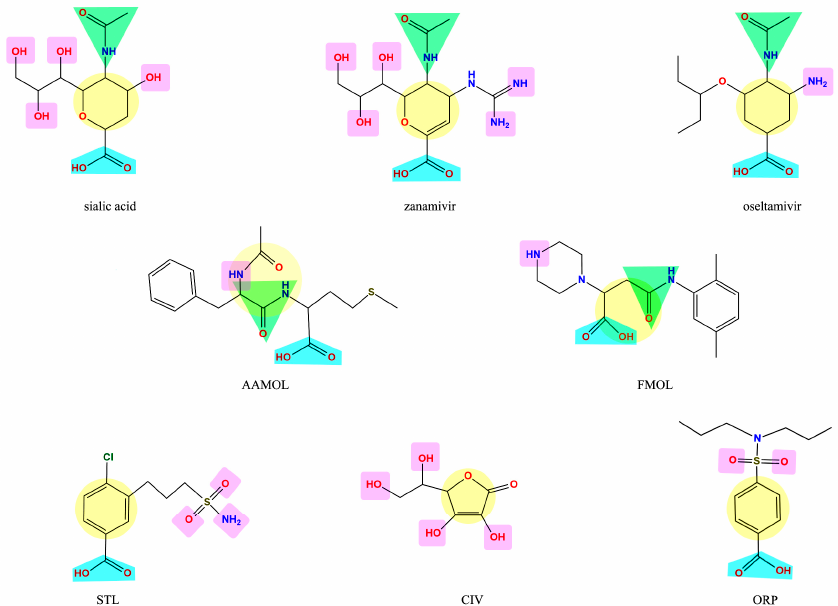
Figure 1. Display of structural similarities between sialic acid and two neuraminidase inhibitors (reference drugs) and the five proposed scaffolds. The structural similarities are coded by colored shapes: yellow circles—the aliphatic ring; blue trapezoids—the carboxyl group; green triangles—the amide group; purple squares—the groups that have capacity to form hydrogen bridges.